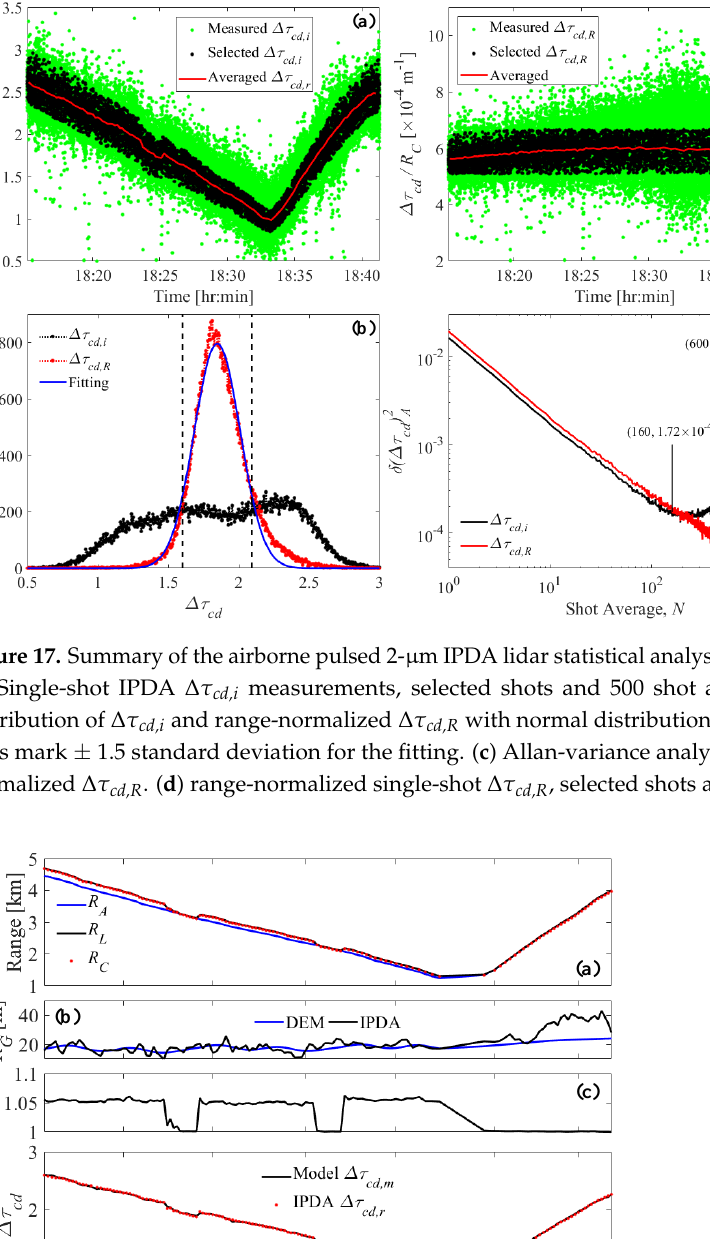
Figure 16. Airborne pulsed 2-μm IPDA lidar measurement and retrieval results during Spiral 1 con- ducted before sunset. ( a ) Airborne altitude, R A , as compared to LOS, R L and IPDA column measure- ment, R C . ( b ) Estimated ground elevation, R G , as compared to DEM results. ( c ) Corresponding C L profile used for converting R A to R L . ( d ) IPDA Δ τ cd measurement after processing and 10-s (500 shots) average, Δ τ cd,r compared to model Δτ cd , Δτ cd,m , obtained from MGD. ( e ) IPDA retrieved XCO 2 , X cd,r , compared to model driven XCO 2 , X cd,m and corresponding x cd in situ measurements. Results ob- tained using 2 GHz and 5 V e-APD bias voltage.